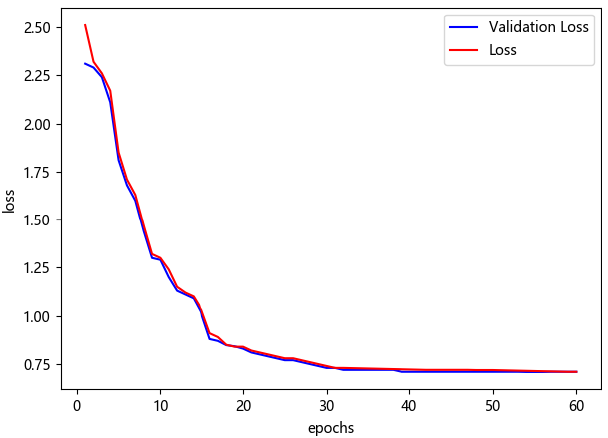
Figure 8. The loss curve of MCF-Net on CAER-S dataset.